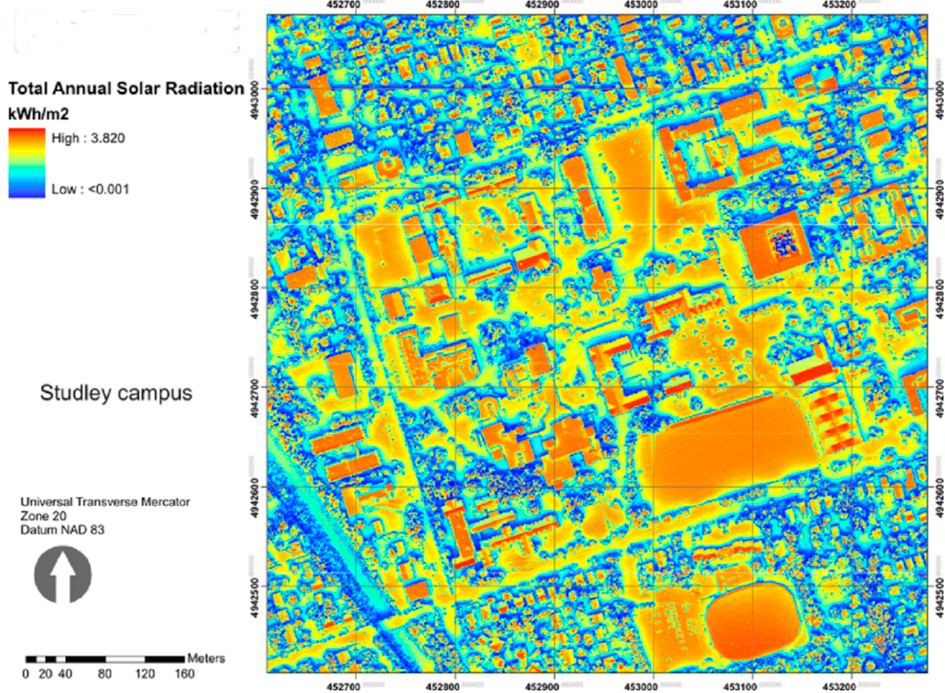
Figure 7. LiDAR-based solar map of Studley campus, Dalhousie University, Halifax, Nova Scotia